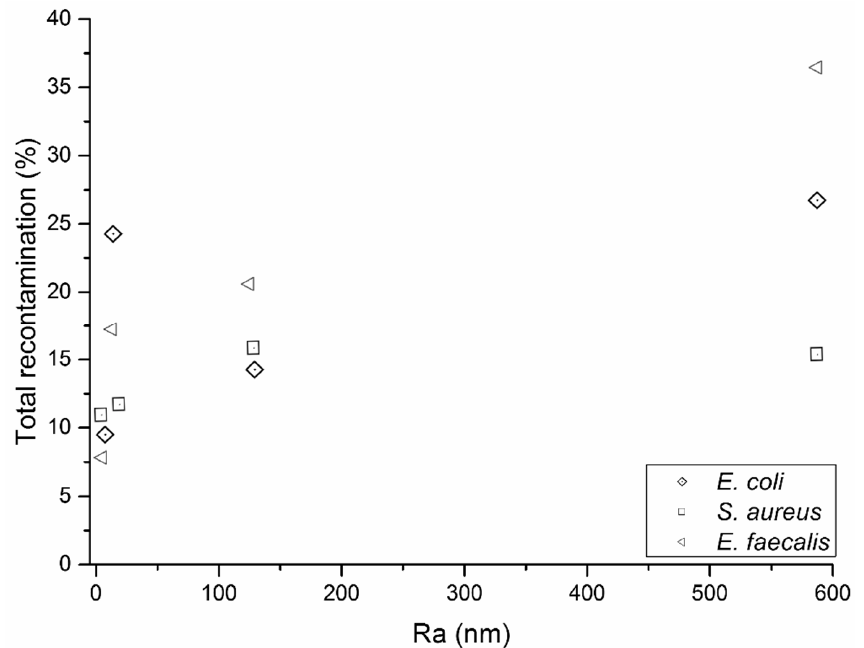
Figure 2. Total recontamination of surfaces by Lyocell nonwoven wipes versus the average roughness (R a ) of the healthcare surface being wiped.